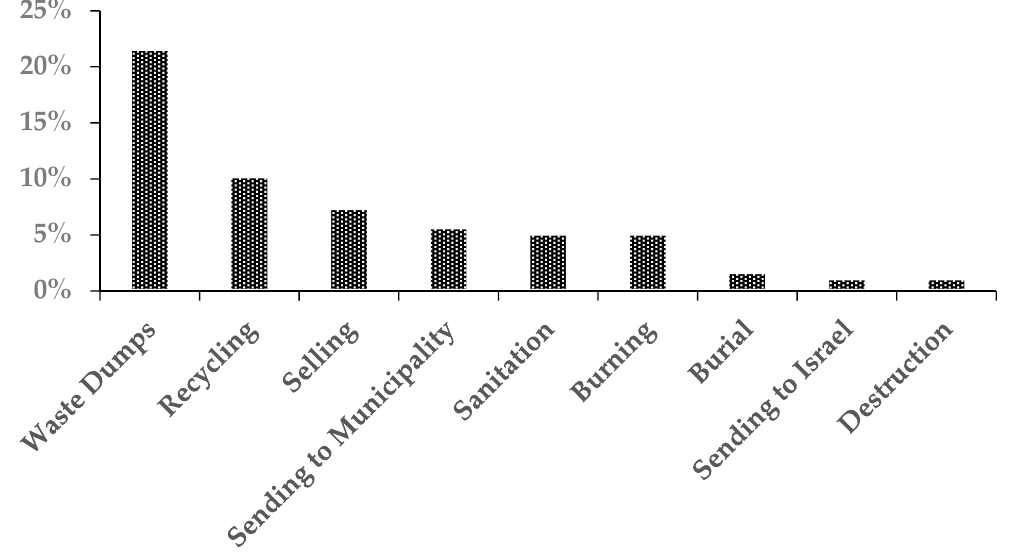
Figure 10. Percentages of industrial waste disposal methods.